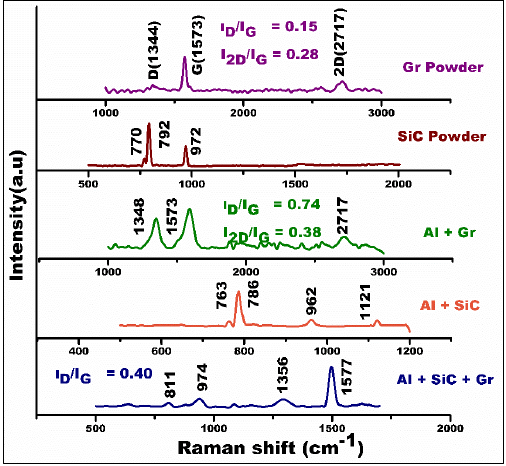
Figure 4 . Raman spectrum of powder and various composites fabricated at 2200 rpm. Graphite is abbreviated as Gr.